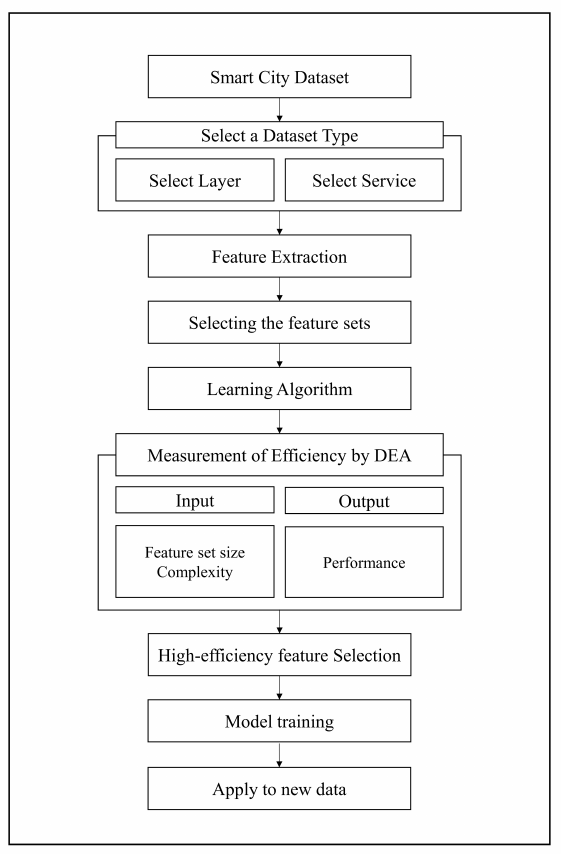
Figure 1. Process measuring efficiency of features by applying